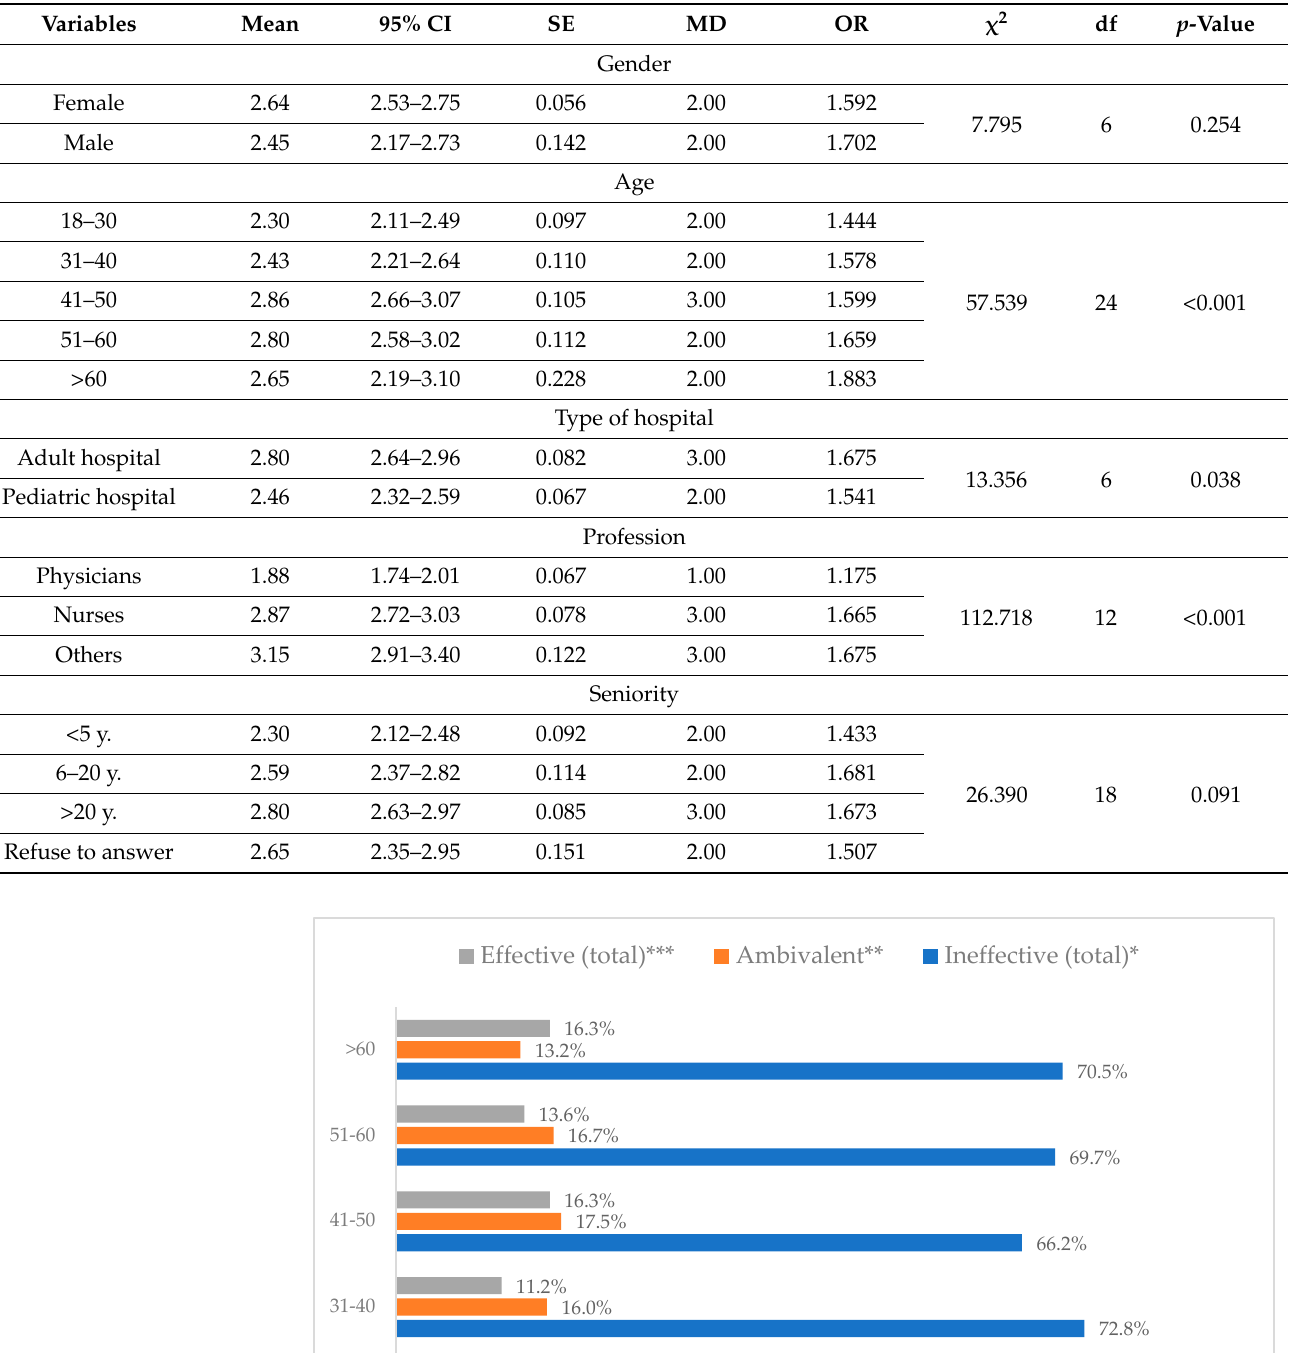
Table 8. Taking preparations with inosine to prevent influenza virus infection by sociodemographic category ( N = 950).